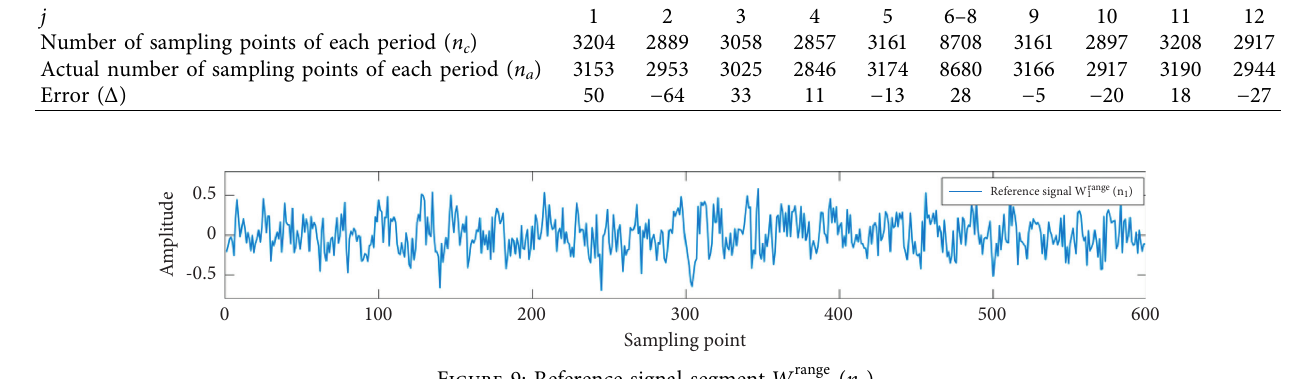
Figure 9: Reference signal segment W range Table 4: The optimal offset τ opt